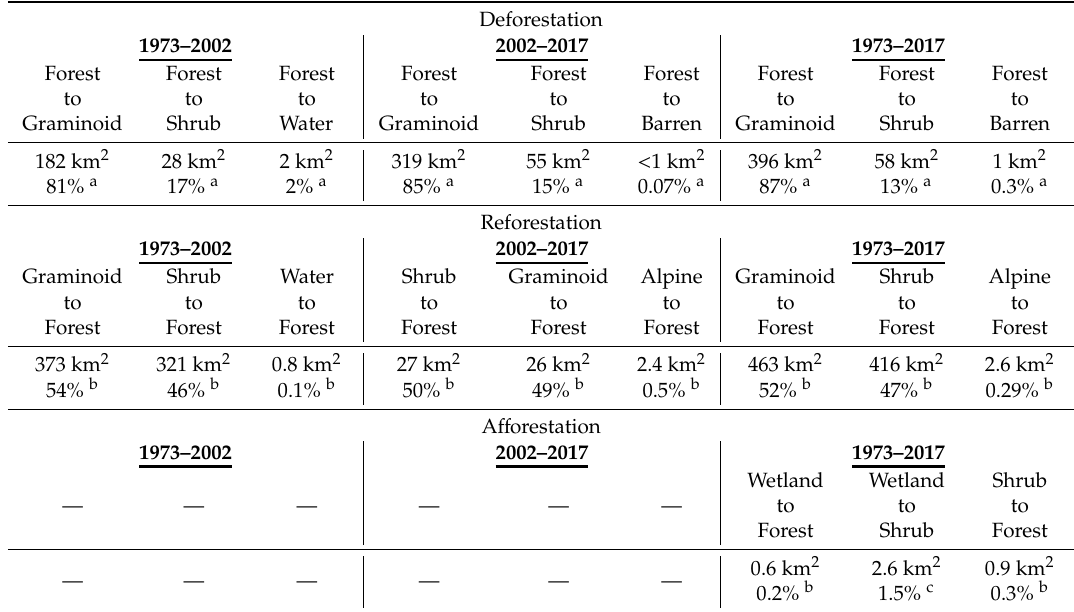
Table 6. Area and percent of prominent land-cover change patterns estimated for each period.